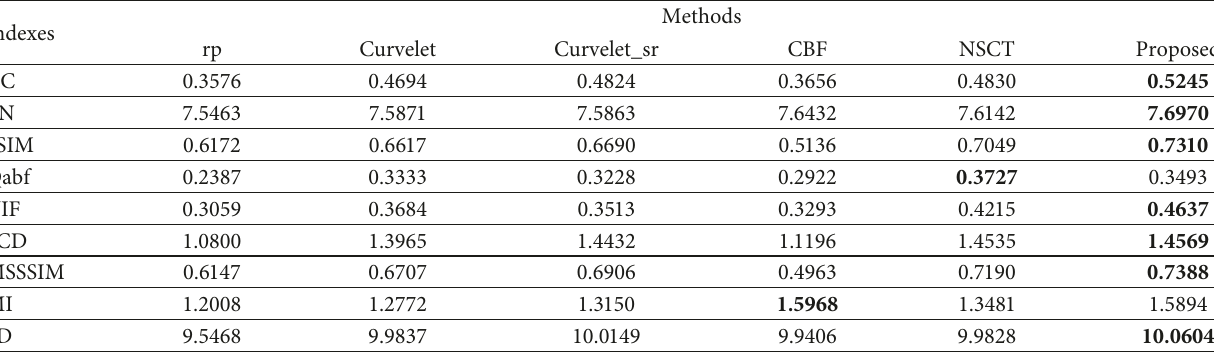
Table 1: Different fusion methods are compared quantitatively, and the best fusion results are highlighted in